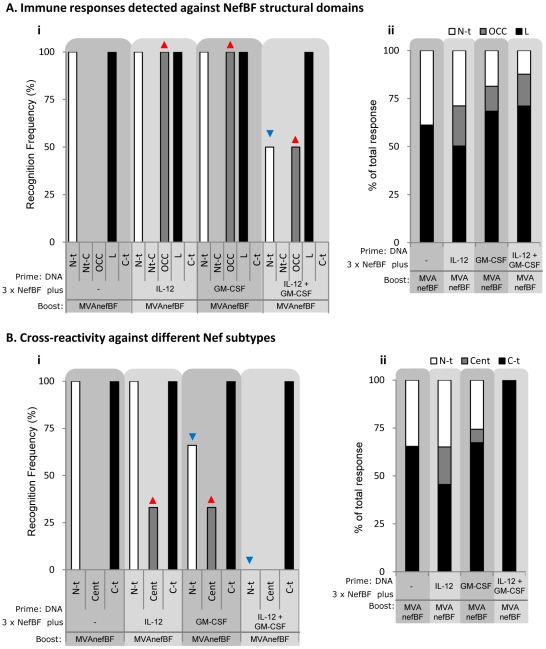
The use of DNA-IL-12 or DNA-GM-CSF during the priming phase in DNA/MVA schemes enhanced the breadth of the cellular response induced.
i Recognition frequency represent the proportion of experiments in which a positive IFN-γ ELISPOT response was found for each protein domain. ii Bars show the percentage of the whole response (obtained from the sum of the responses directed against each of the five peptide pools) which is directed towards the different Nef domains. Red and blue arrows denote increments and decreases compared to control group respectively. A) NefBF peptides were mixed in five pools representing the structural domains of Nef protein: N-terminal domain (N-t, 1–83 aa), N-terminal Core (Nt-C, 84–115), Oligomerization domain+Central Core (OCC, 116–159), the Loop of the protein (L, 160–187) and C-terminal (C-t, 188–205). Data are from two or three independent experiments for DNAck or control groups, respectively. B) PTE peptides were mixed in three pools, representing N-terminal (N-t, 1–83 aa), Central (C, 84–159) and C-terminal (C-t, 160–205) Nef domains. Data are from three or four independent experiments for DNAck or control groups, respectively.